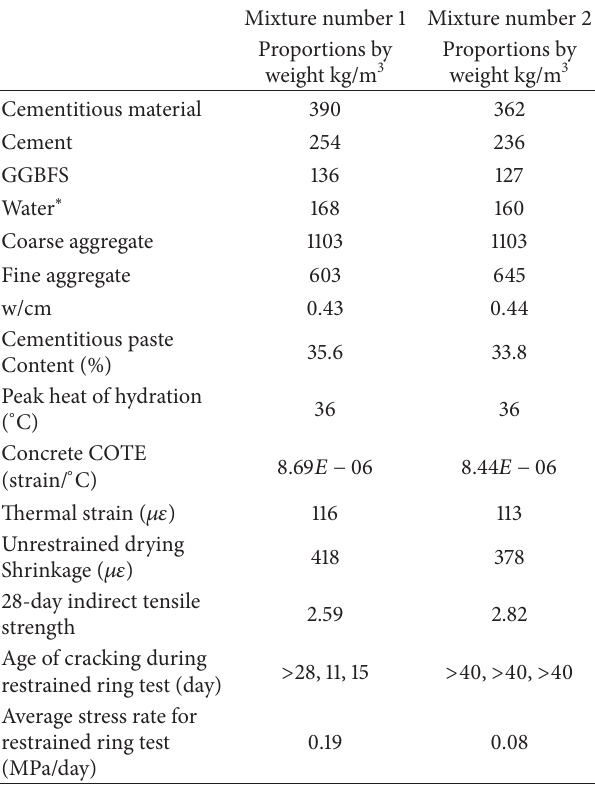
Table 2: Mixture proportions and experimental results for Mixture number 1 and Mixture number